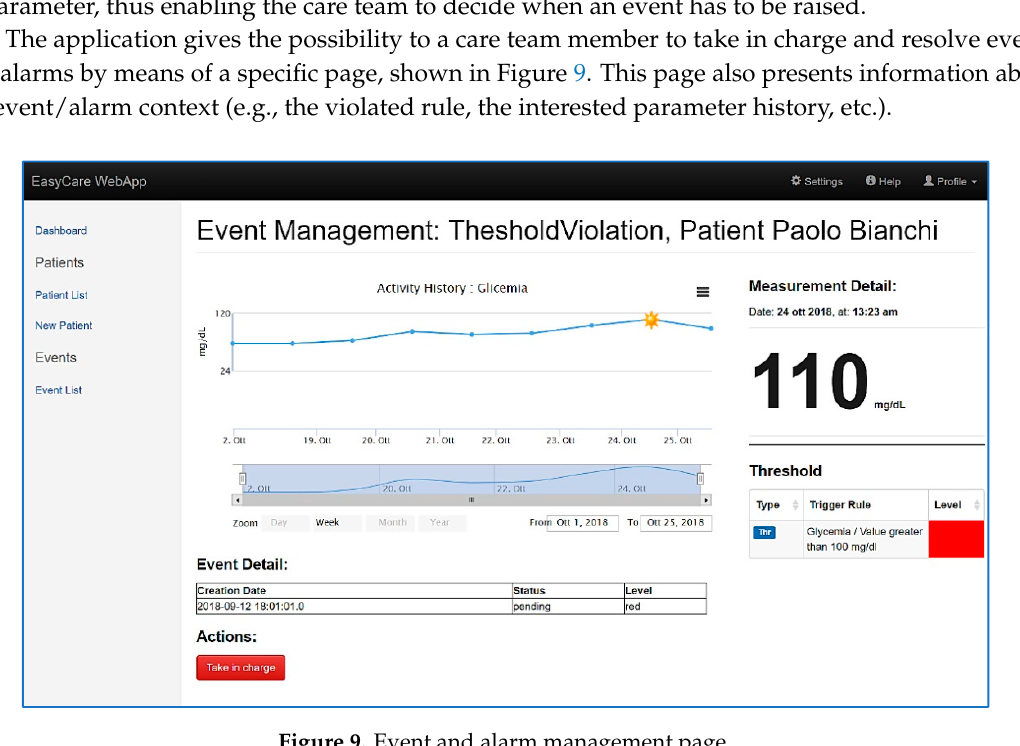
Figure 9. Event and alarm management page.